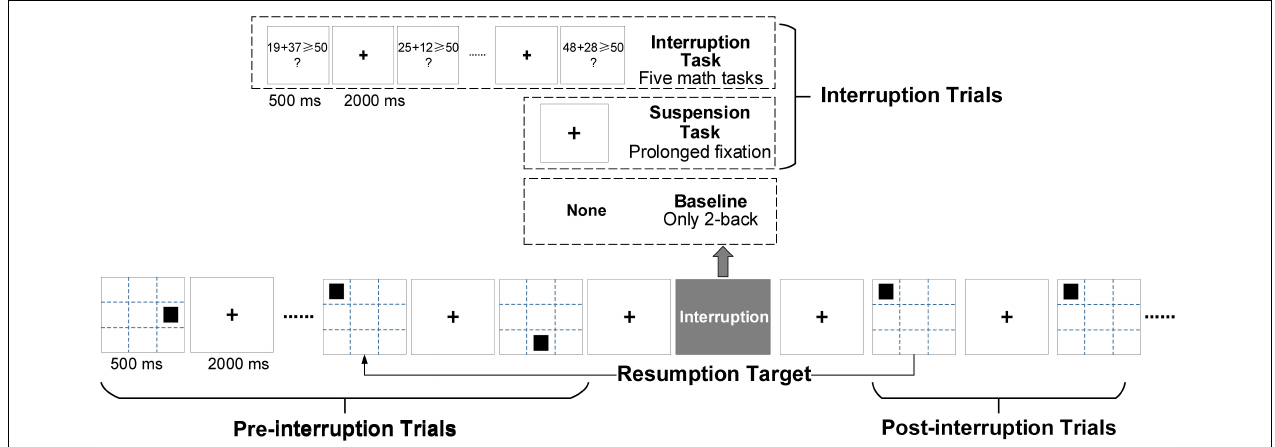
FIGURE 2 | Experimental design based on the spatial 2-back task. There were three types of working memory (WM) tasks. In the interruption task (IT), the interruption consisted of five math tasks. In the suspension task (ST), the primary task (2-back) was suspended by prolonged cross-trial fixation (of the same duration as the math tasks). In the baseline condition, only the 2-back task was performed.